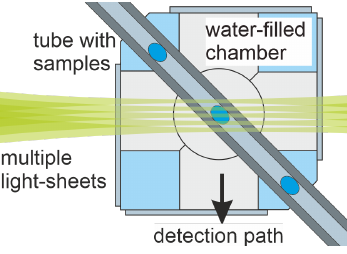
Figure 1. Schematic of the measurement configuration with tube-guided samples illuminated with multiple light sheets. The inclination of the tube of 45 ◦ o ff ers the option of a 90 ◦ -detection between illumination and detection path.